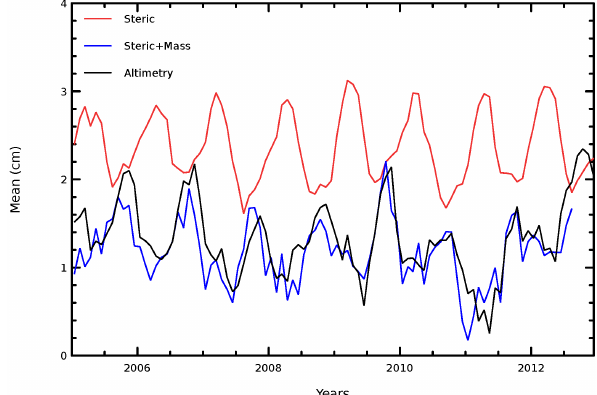
Figure 5. Temporal evolution of the steric DHAs from Argo data (red), the summed steric + mass contributions (blue) and the altime- ter SLA (black).